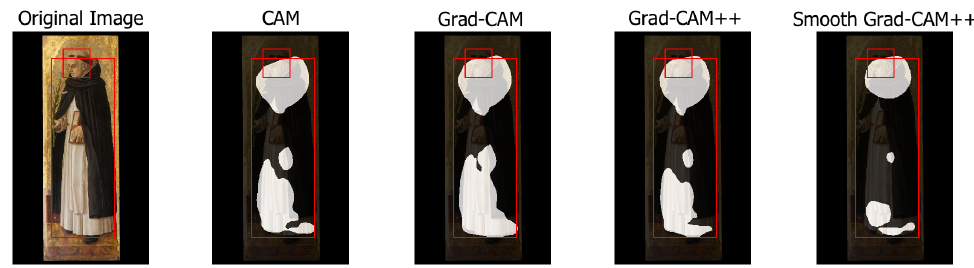
Figure 15. Class activation maps extracted from a paining of Saint Dominic. The rather generic vest attribute is identified by focusing on its double color.